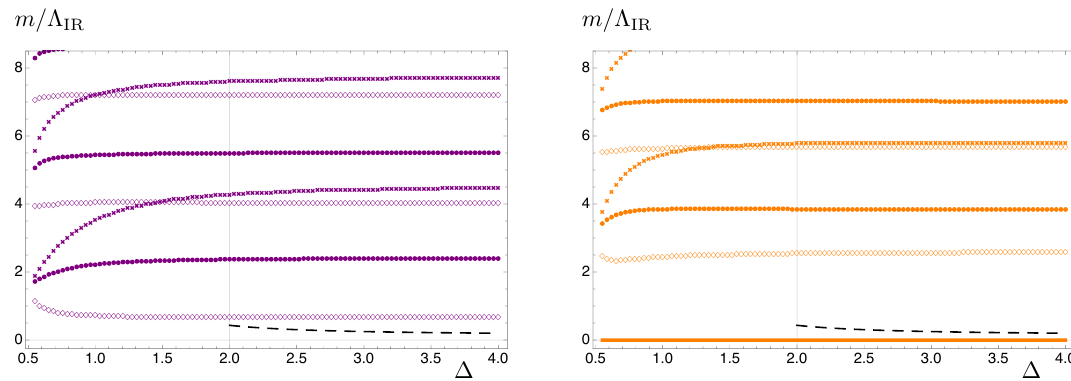
Figure 4 . Model I. Fermionic spectrum as a function of ∆ for ∆ R = 1 . 6 , 2 . 5 , 4 (diamonds, dots, crosses), x F = 1 , g 5 = 8 , r 1 = 10 − 12 , r 2 = 15 . The decay constant ˜ f is represented by the dashed black line. We indicated by a vertical line the value ∆ = 2 below which the flavour symmetry is explicitly broken. The left and right panels correspond to imposing (+) and ( − ) IR boundary conditions, respectively. These plots are normalised to the IR scale Λ IR . The solid line in the right panel indicates the presence of a massless state.